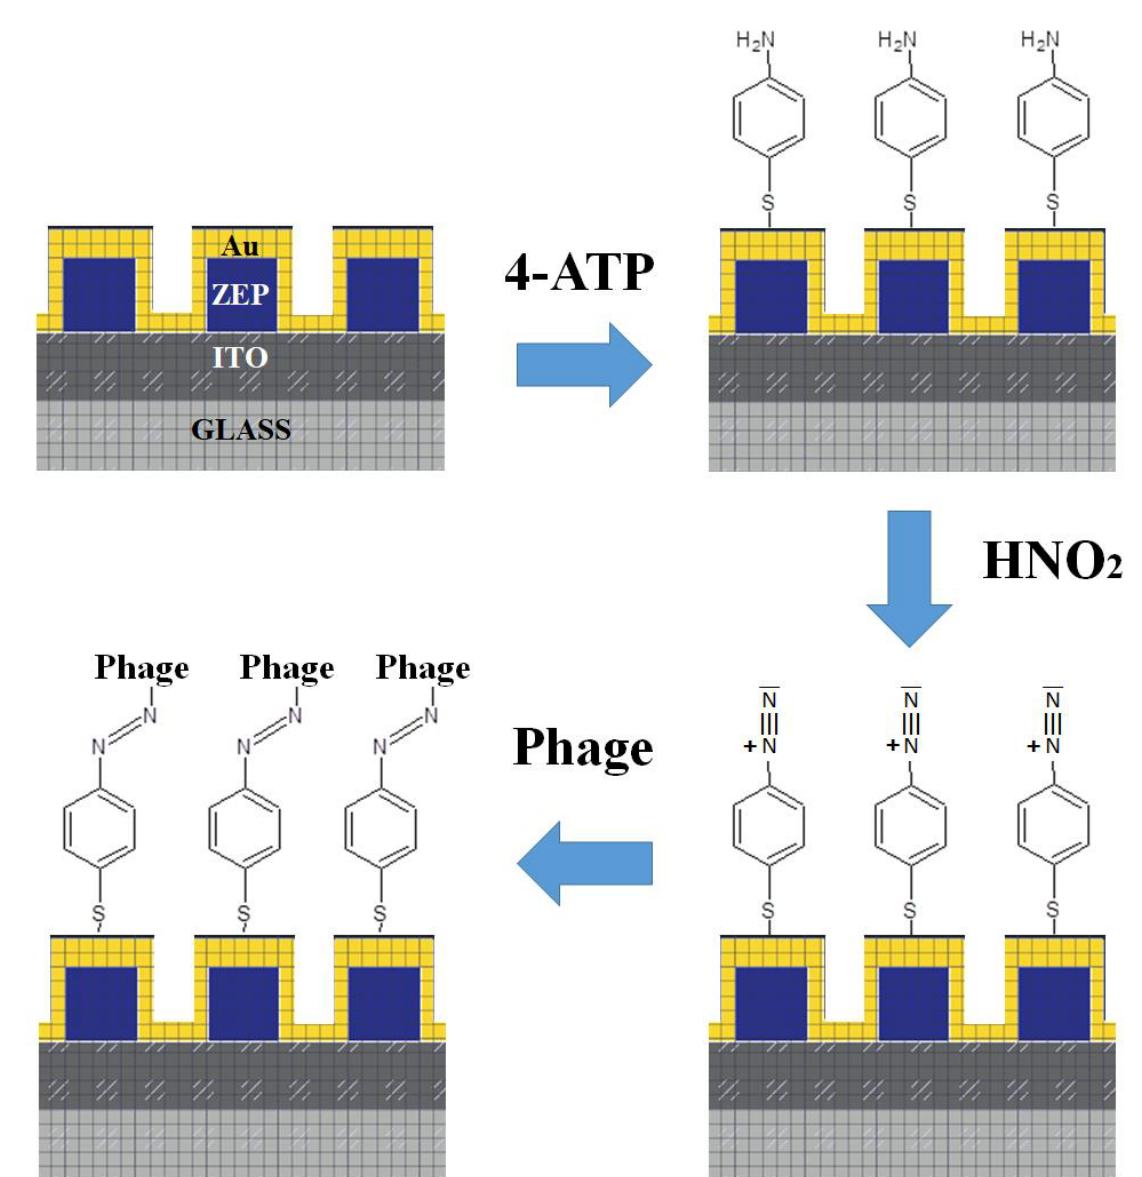
Figure 2. Schematic representation of the patterned NCs and the Au-surface functionalization.